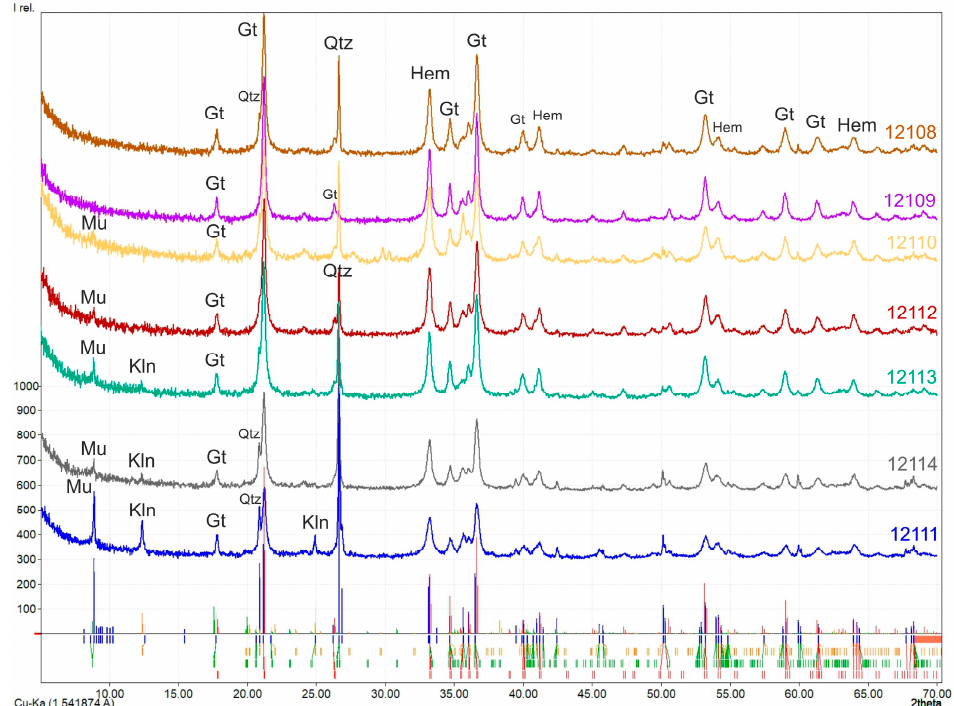
Figure 2. XRD patterns of the pisolith samples. Mu—muscovite; Kln—kaolinite; Gt—goethite; Qtz—quartz; Hem—hematite. The numbers (12108, etc.) denote sample numbers. The intensity scale is the same for all the patterns. (Individual XRD patterns with additional information are in the Supplementary file).